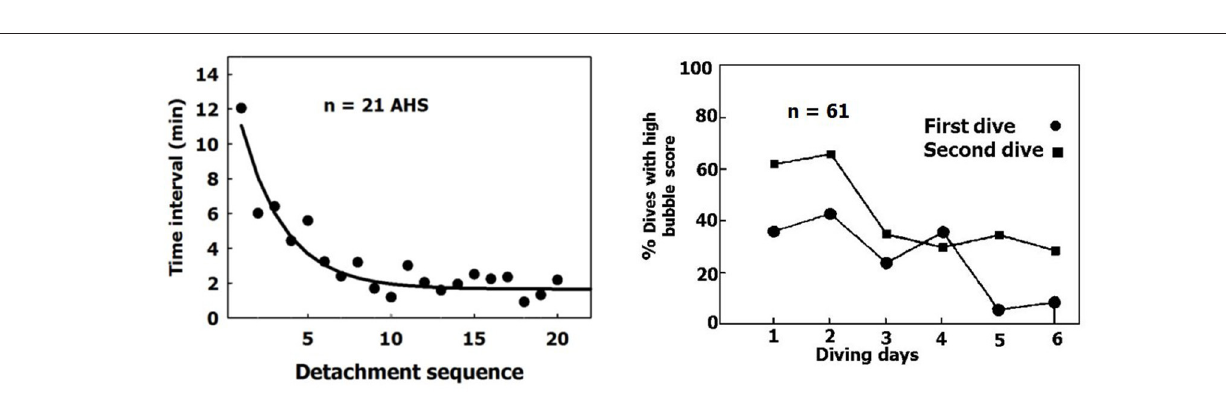
FIGURE 12 | Activation of AHS. (Left) Time intervals between bubble detachments from the AHS as a function of the sequence of detachment from the same AHS. The first value is the time from decompression (adapted from Arieli and Marmur, 2014 with permission). (Right) Percentage of high bubble grades after the first and second dives on the same day (adapted from Dunford et al., 2002 with